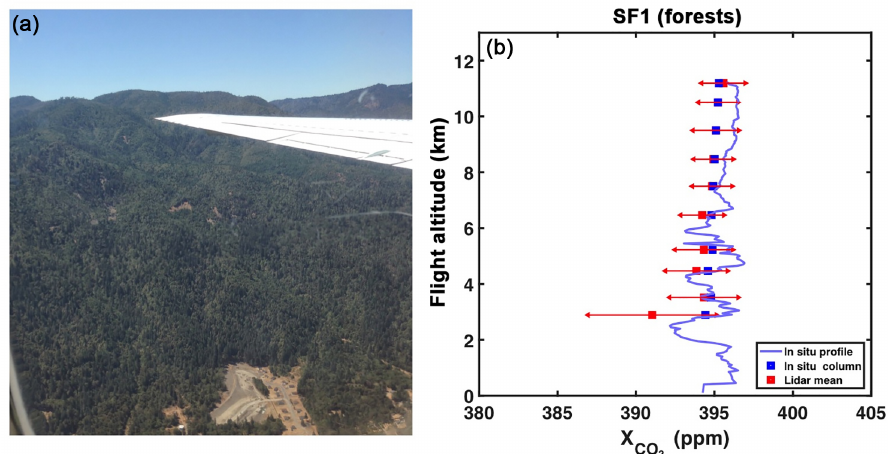
Figure 12. (a) Photo of northern CA coastal redwood forests taken from the aircraft on 2014 SF1. (b) Summary plot of the in situ (blue) and retrievals from lidar measurements (red) vs. altitude. The lidar results are for XCO 2 retrievals based on 10s average from the altitude where the results are plotted, and the error bars are for 1 SD. The XCO 2 computed from the in situ sensor from the plotted altitude to the ground is shown as the blue dots.